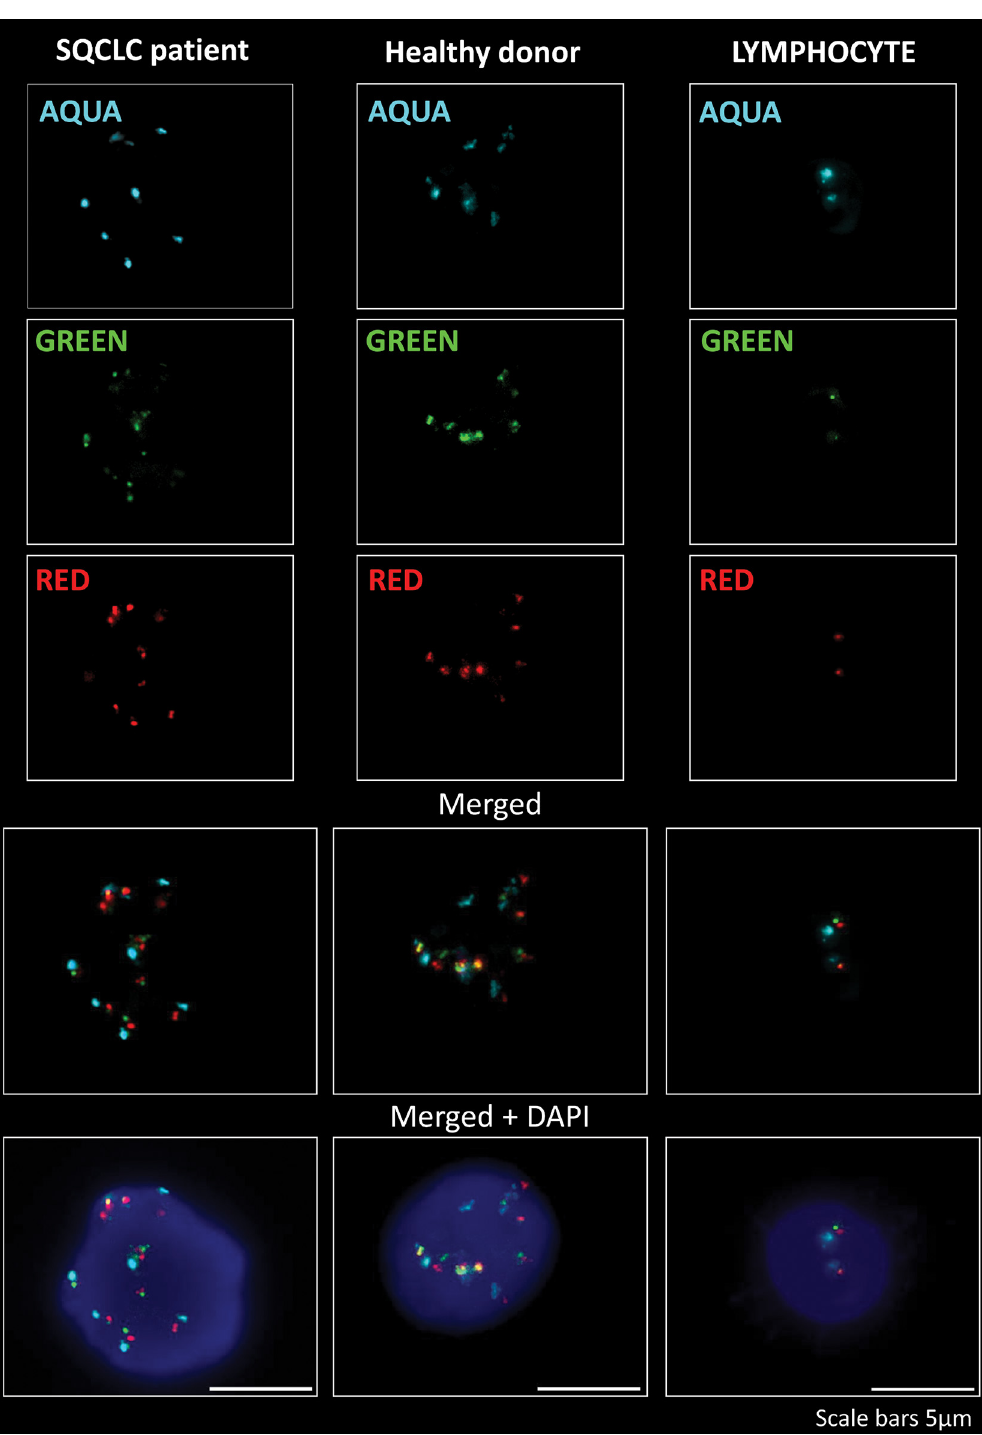
PLOS ONE | DOI:10.1371/journal.pone.0142891 November 16,